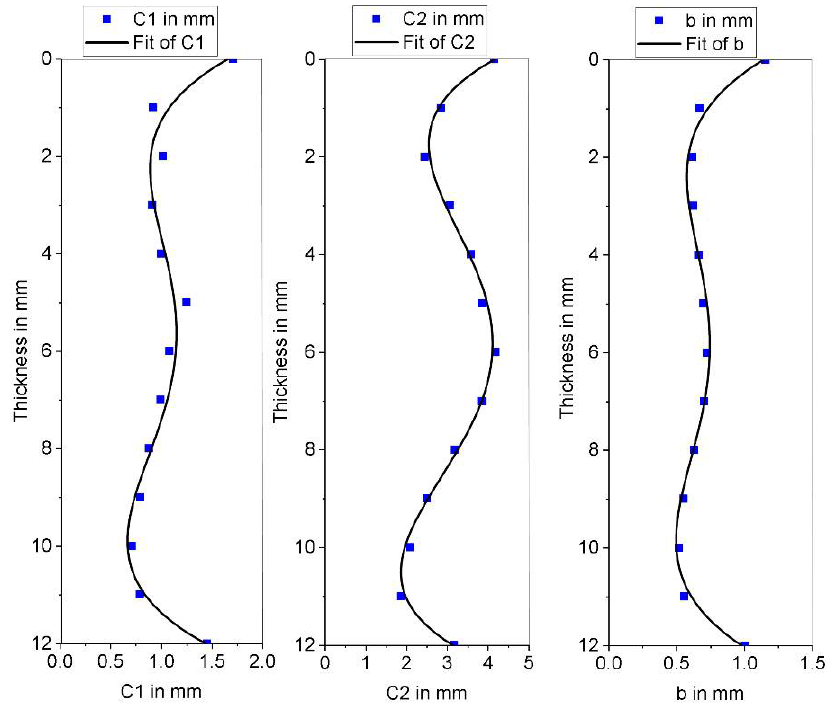
Figure 11. The fitting of the parameters c 1, c 2 and b as a function of the weld depth.